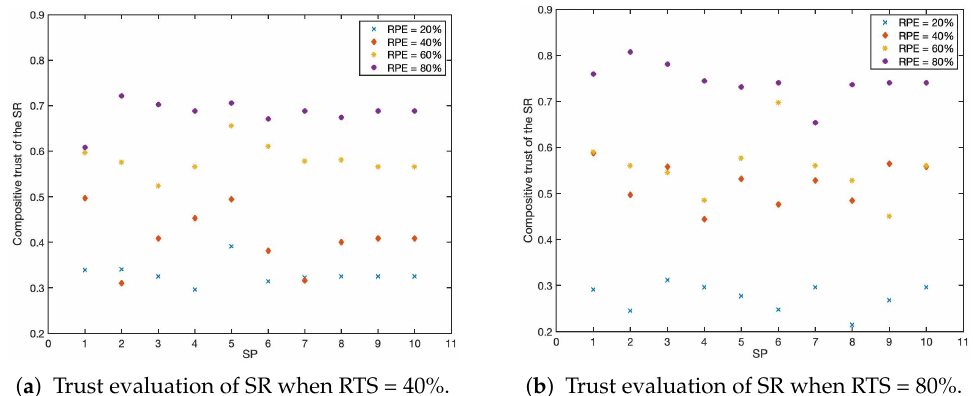
Figure 6. Trust evaluation of SR with different RPE and